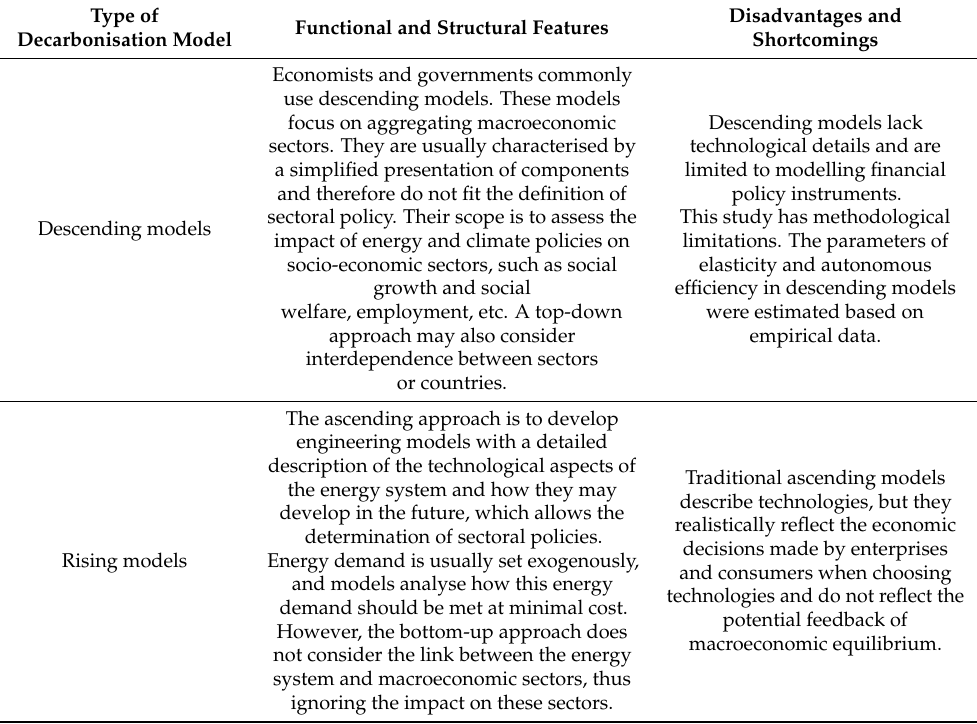
Table 4. Advantages and disadvantages of decarbonisation